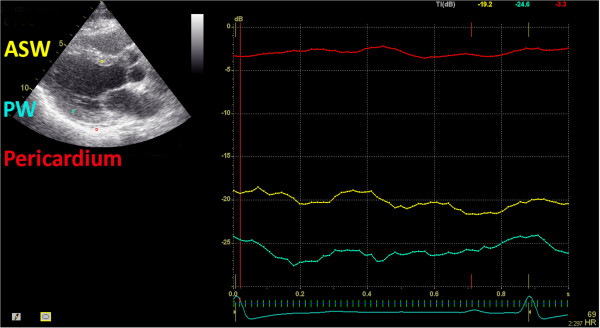
Assessment of left ventricular fibrosis by calibrated integrated backscatter (IB) in the parasternal long axis view. A 9 × 9 pixel sample volume is placed in the mid-myocardium of the basal anteroseptum, posterior wall, and pericardium, and is tracked throughout the cardiac cycle. In this example, calibrated IB for the anteroseptum is obtained by subtracting average pericardial IB intensity (−3.3 dB) from average myocardial IB intensity of the septum (−19.2 dB), which results in a calibrated IB for the septum of −15.9 dB.